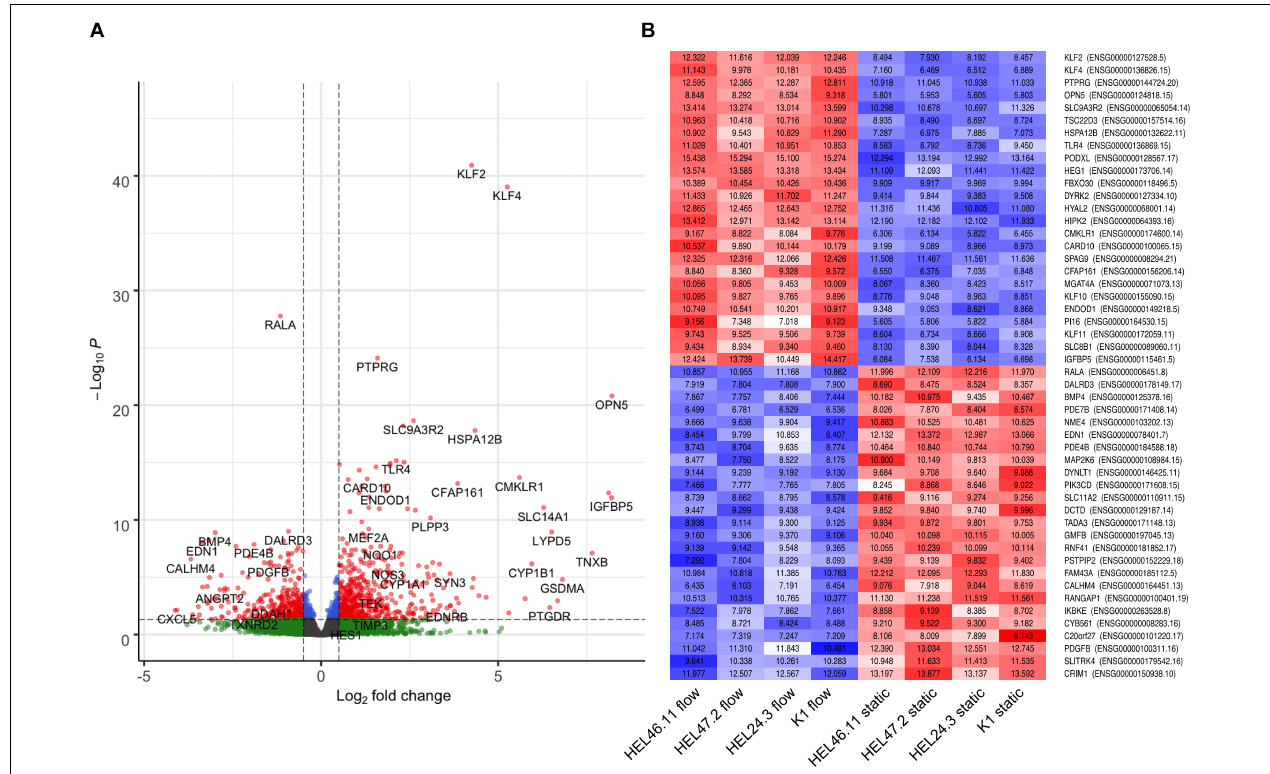
FIGURE 6 | Bulk RNASeq analysis of the effect of flow compared to static condition. (A) , A volcano plot of differentially expressed genes in flow compared to static hiPS-ECs. (B) , Heat map of the 50 most significantly changed genes by flow. Red denotes upregulation and blue